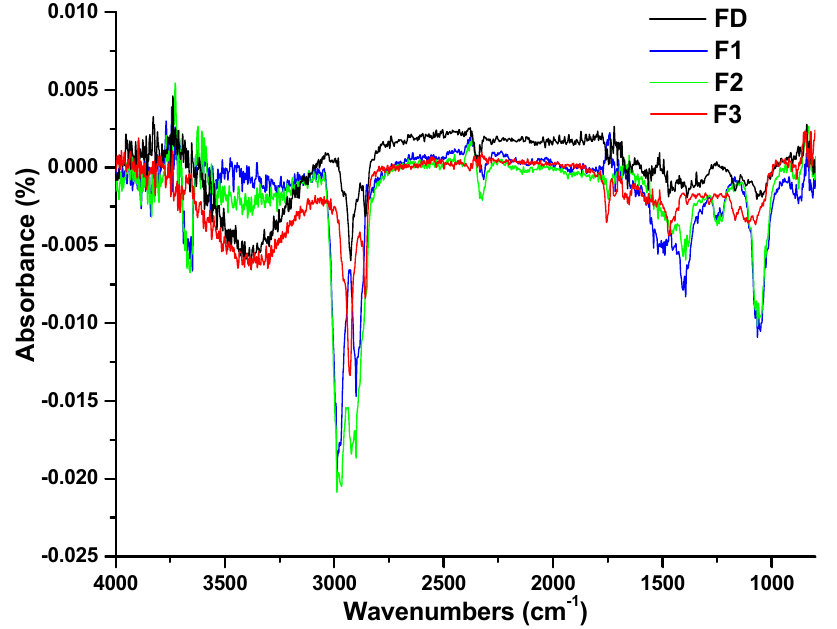
Figure 2. FTIR spectra of dopamine- and cyclotides-treated metal disk samples. For FD, spectra were collected using an untreated sample as background; for F1, F2, and F3, FTIR spectra were collected using FD as background. Metal disk samples treated with dopamine (DA), P1, P2, and P3 were denoted as FD, F1, F2, and F3, respectively.